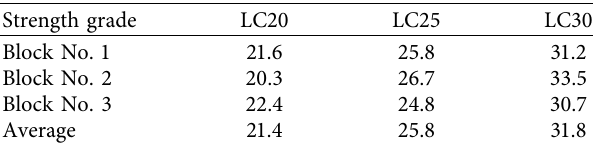
Figure 3: Concrete blocks in the compressive strength test. Table 3: Compressive strength of the lightweight concrete (unit: MPa).